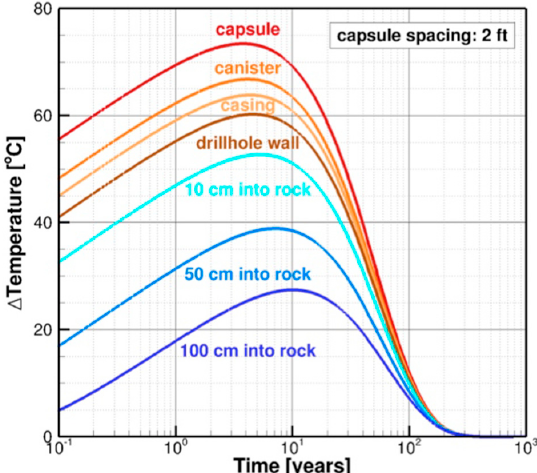
Figure 3. Evolution of temperature change for an initial heat release of 100 W per waste capsule with capsule spacings of 2 ft (0.6096 m) [27].